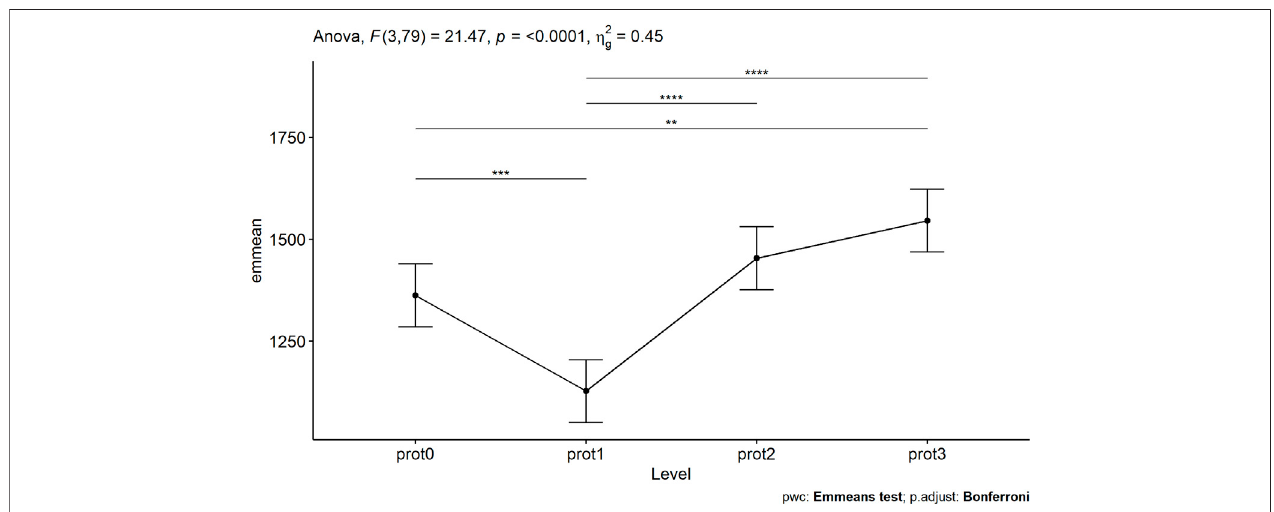
FIGURE 8 | Estimated mean annual precipitation for each level of protection based on 20 years of precipitation data (period 2000 – 2020). Statistical differences among the protection categories are indicated with *. prot0: unprotected area, prot1: National Reserve, prot2: National Park, prot3: Strict Nature Reserve. Horizontal lines on top indicate statistical differences between levels of protection